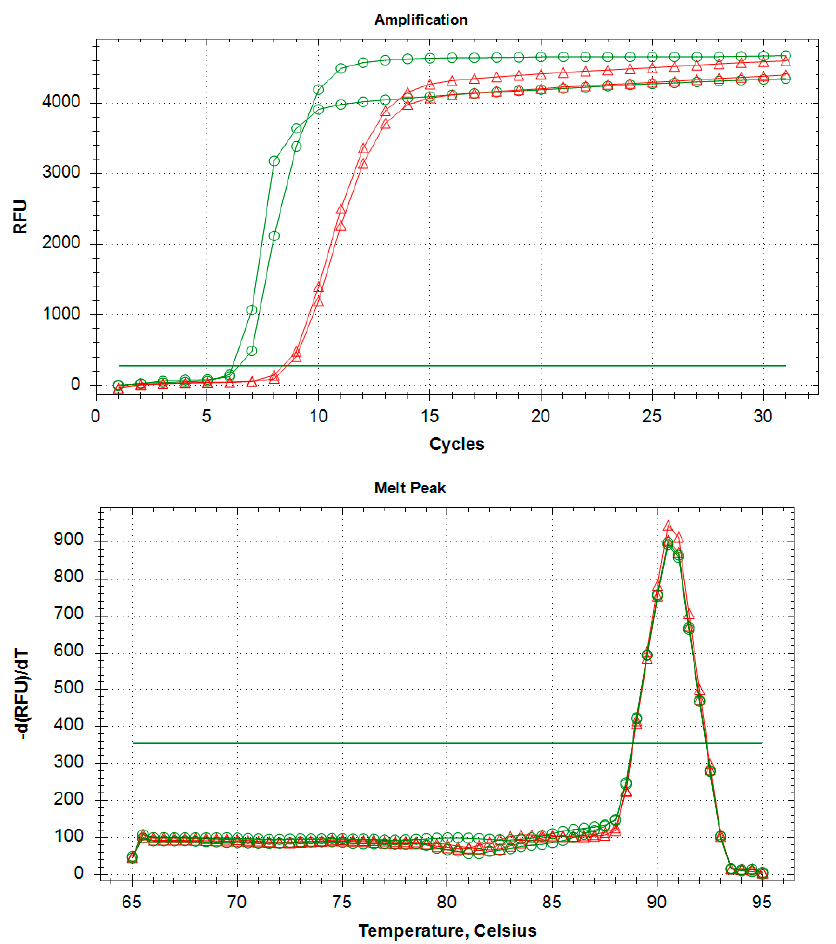
Figure 1. Real-time LAMP amplification curves from adults (green with circles) and frass (red with triangles) of WTB.